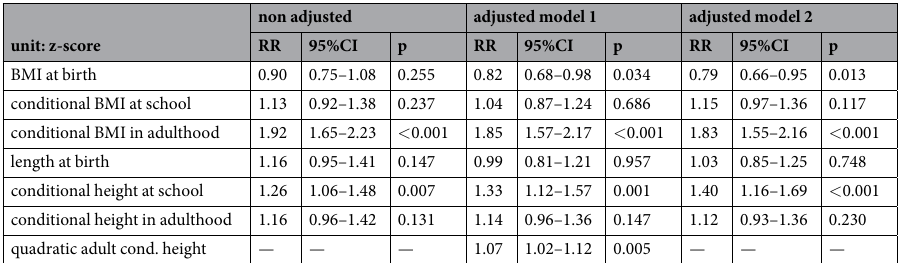
Table 5. Poisson regression of the association of growth patterns and hypertension in a population–based birth cohort born in 1978–79 in Ribeirao Preto, Brazil (N = 1141). Unadjusted model: each anthropometric measure entered into a separate model. Model 1 is adjusted for for gender, type of delivery, preterm birth, maternal hypertension, adult smoking, adult age and adult occupation of the head of the family. Model 2 includes all anthropometric variables entered together in model I. IRR = incidence rate ratio; c-BMI = conditional BMI; c-length = conditional height; 95%CI = 95% confidence